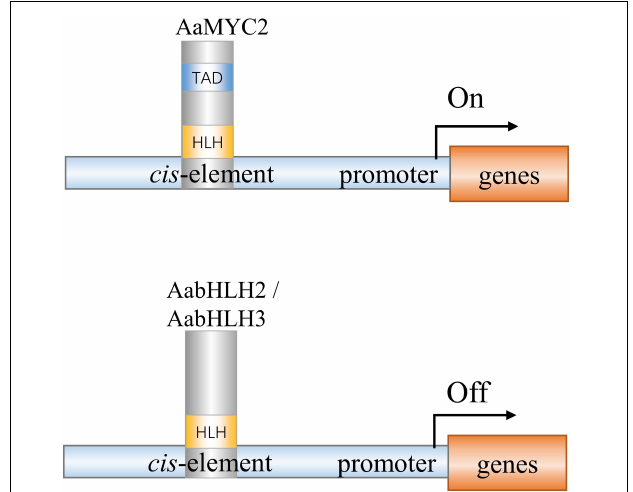
FIGURE 7 | A simplified model of action of AabHLH2, AabHLH3, and AaMYC2 in regulating artemisinin biosynthesis in Artemisia annua . AabHLH2, AabHLH3, and AaMYC2 were all able to bind the G-box-like motifs in the pathway gene promoters. AaMYC2 contains the conserved TAD domain and activates the transcription of the downstream gene. AabHLH2 and AabHLH3 were lacking the conserved TAD domain and repressing the transcription of the downstream